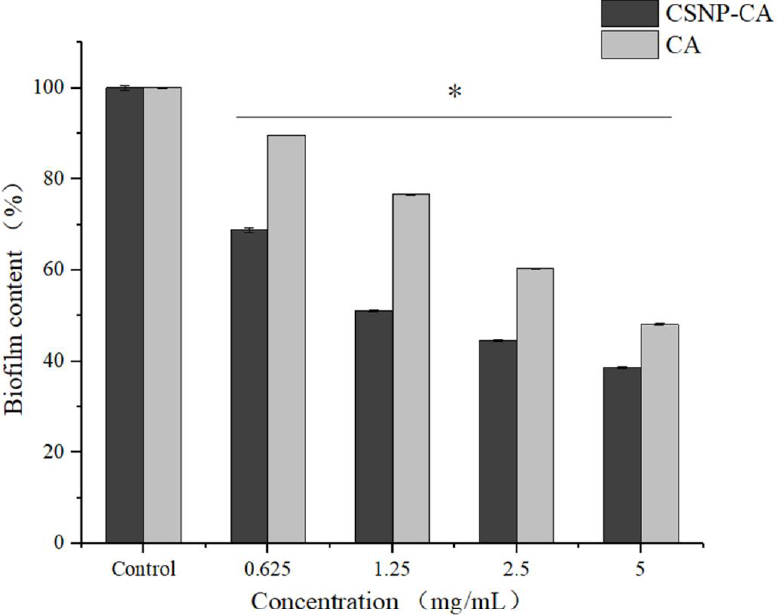
Figure 4. Disruption effects of NPs on mature biofilm in 96-well microplates. The results represent the means and standard deviations (error bars) of three independent experiments. * p < 0.05 for comparison between the untreated and treated groups.